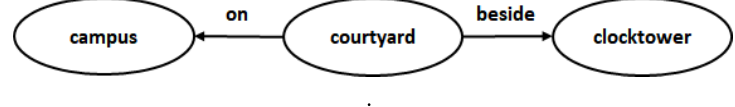
Figure 1. Place graph consisting of two example triplets: <courtyard, on , campus> and <courtyard, beside ,